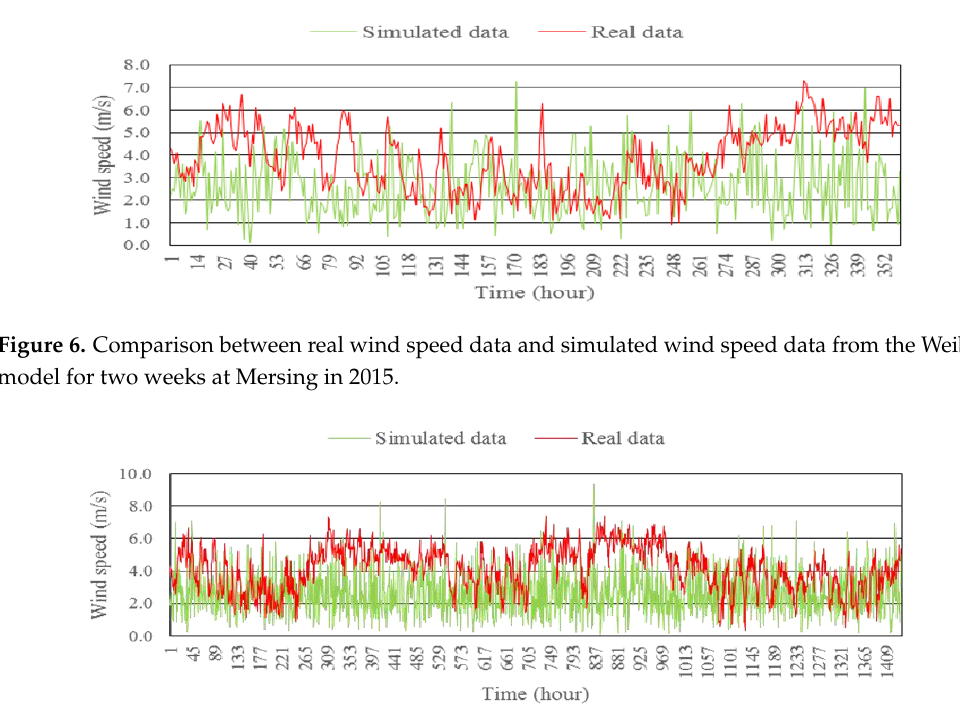
Figure 7. Comparison between real wind speed data and simulated wind speed data from the Weibull model for two months at Mersing in 2015.